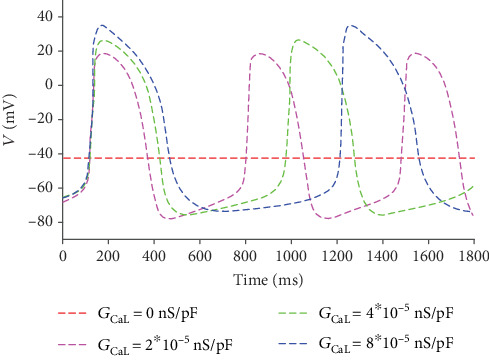
APs corresponding to different GCaL.